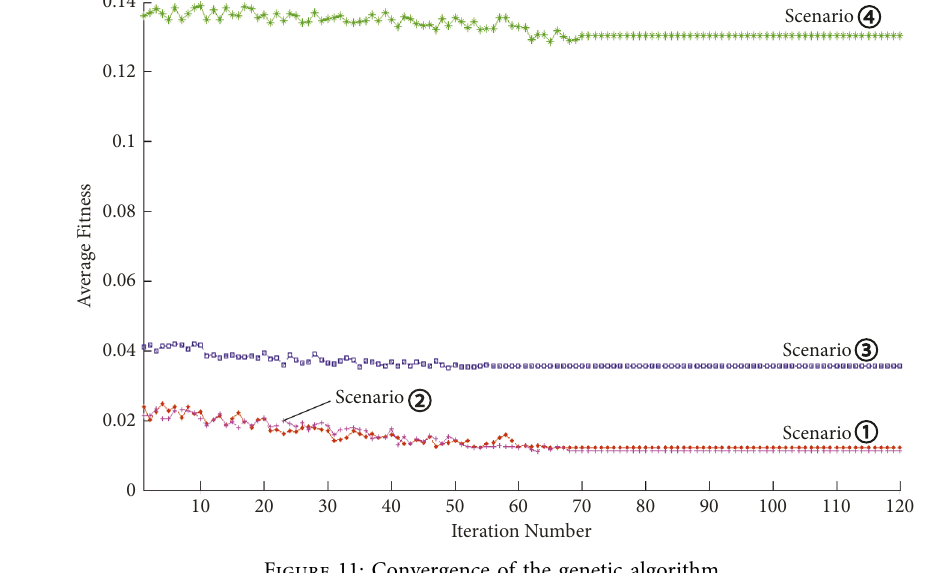
Figure 11: Convergence of the genetic algorithm. Table 5: Calibration results for equation